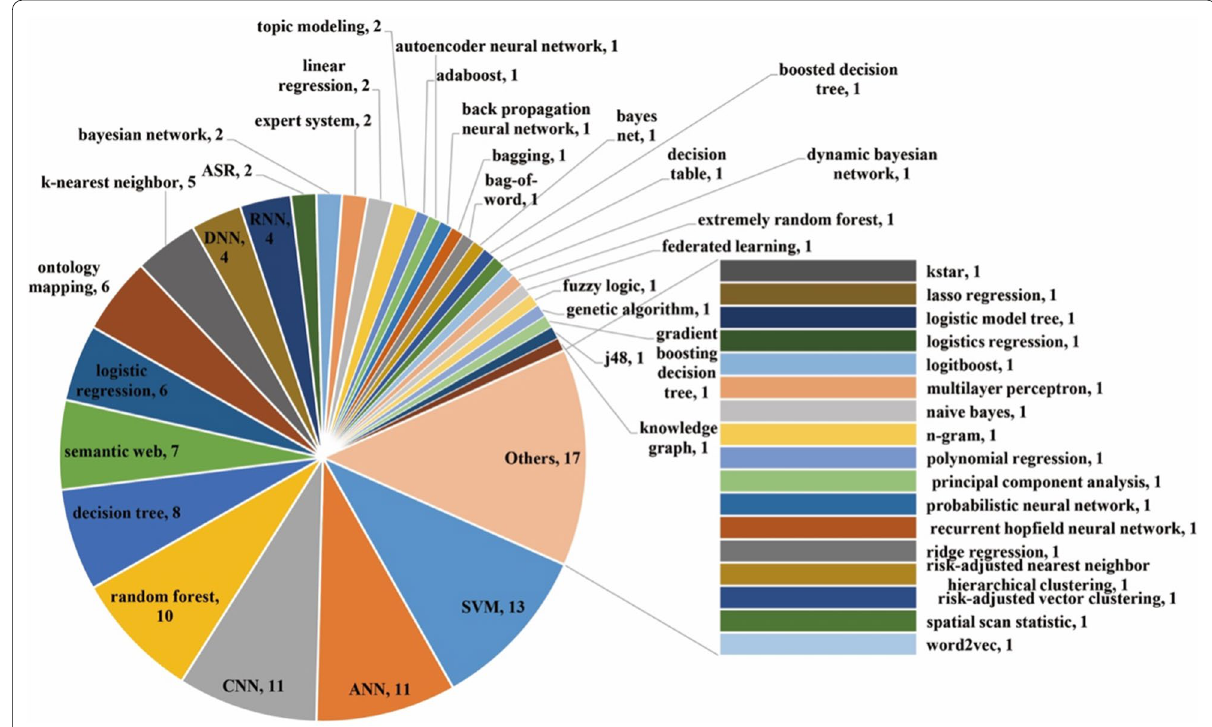
Fig. 8 Distribution of AI technologies